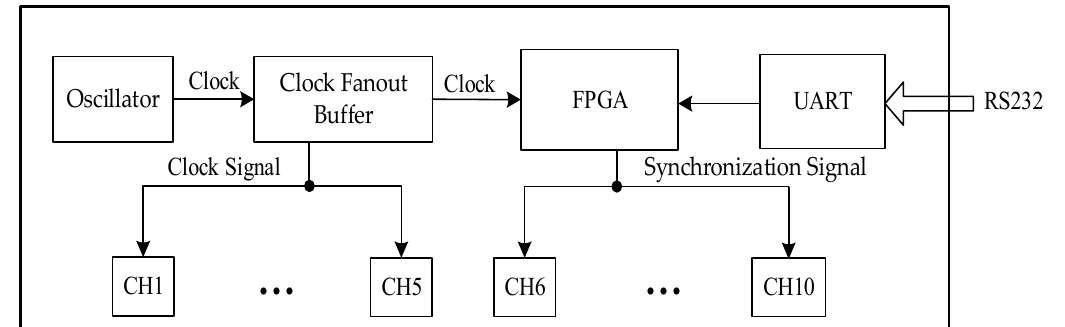
Figure 11. The block diagram of the CSM.